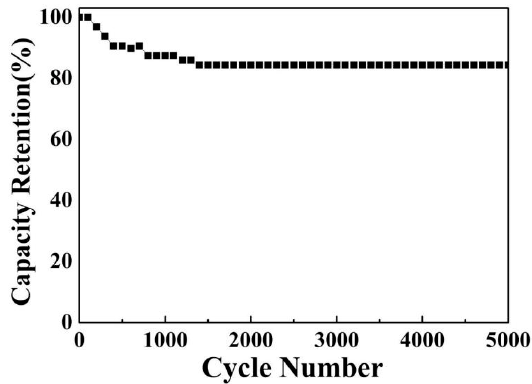
Figure 9. Cycling performance of the Co(OH) 2 /Ni 3 S 2 electrode. Table 1. Comparison of C s of Cu(OH) 2 /Ni 3 S 2 with reported in the literatures.